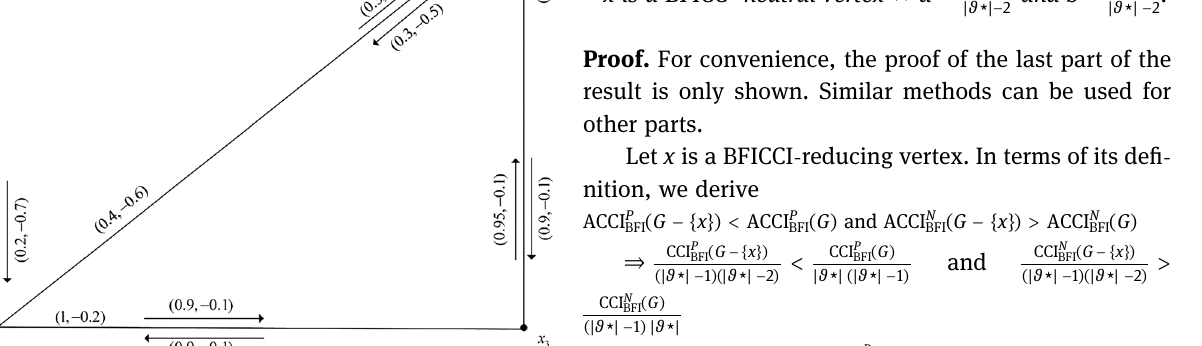
Figure 4: Subgraph of BFIG with G CCI 1.5, −1.8 BFI ( ) ( ) =